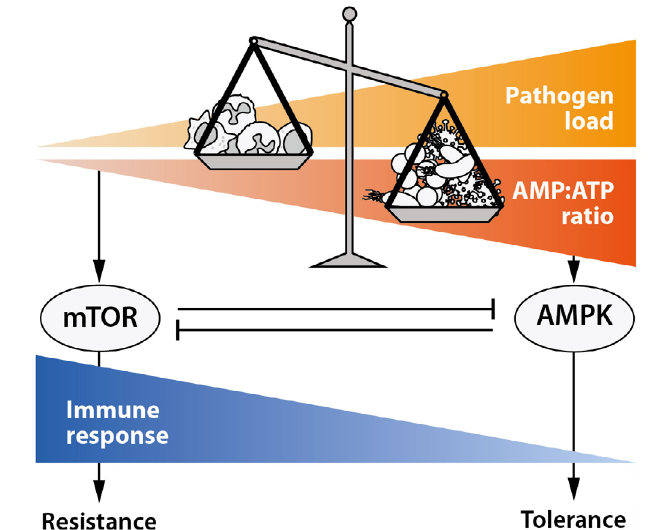
Figure 4. Key signaling pathways mediating pathogen-induced effects on energy metabolism